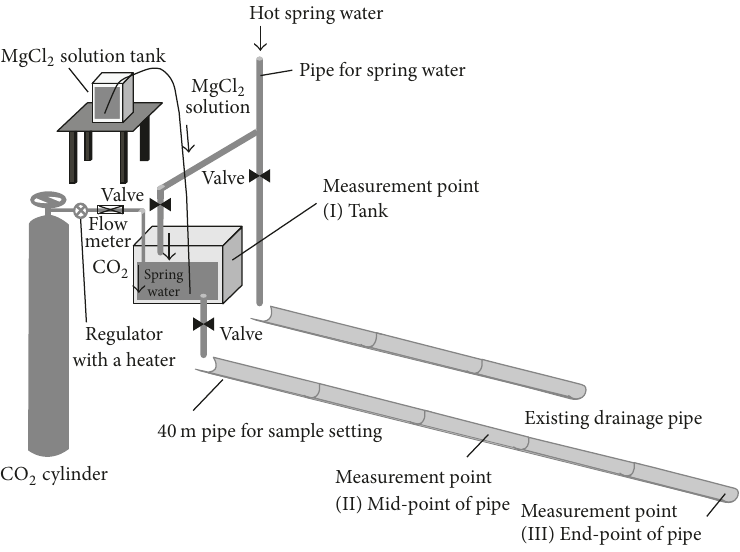
Figure 1: Schematic diagram of the field experiment